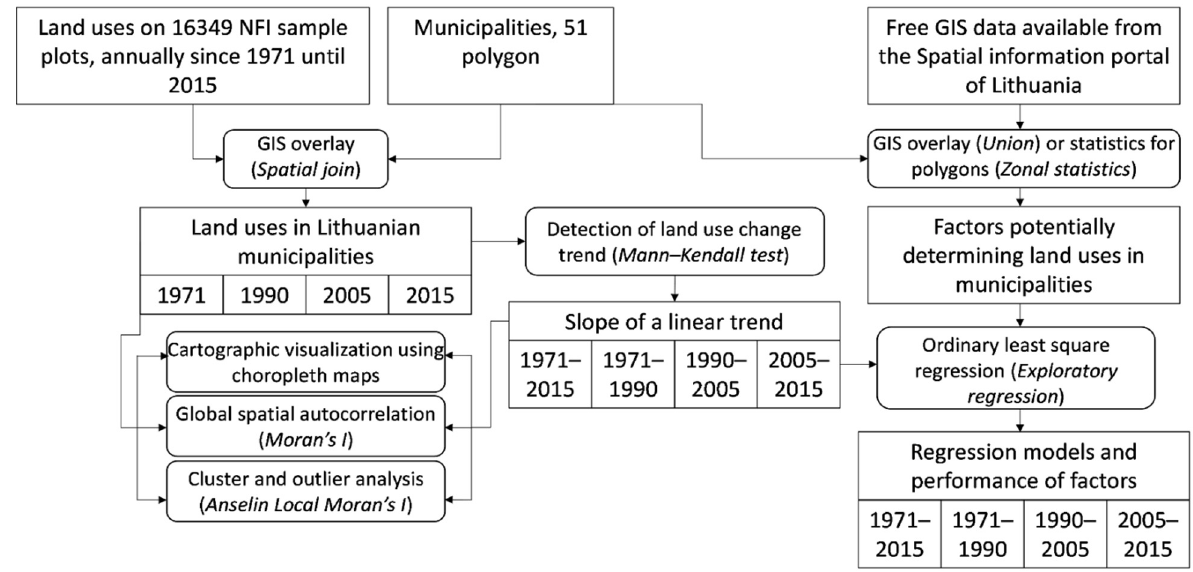
Figure 2. Flowchart summarizing the overall structure of the study.